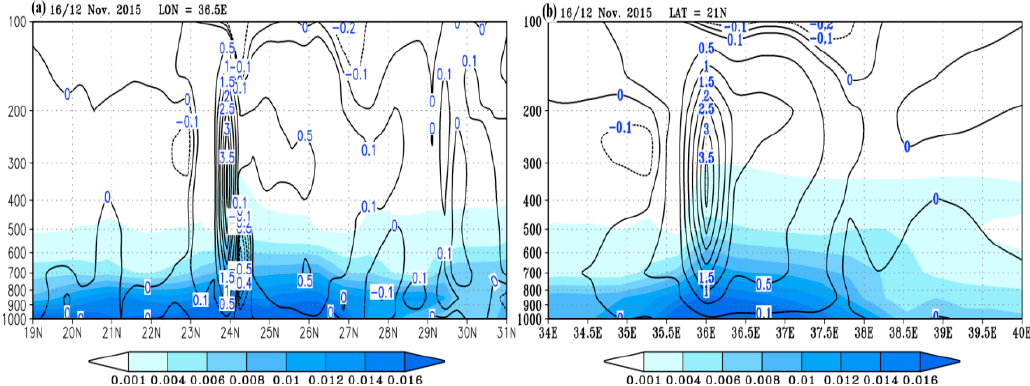
Figure 15. ( a ) Meridional cross section (at 36.5° E) and ( b ) zonal cross section (at 21° N) of vertical velocity (contour, cm s − 1 ) and water vapor mixing ratio (shaded, kg kg − 1 ). velocity (contour, cm s − 1 ) and water vapor mixing ratio (shaded, kg kg − 1